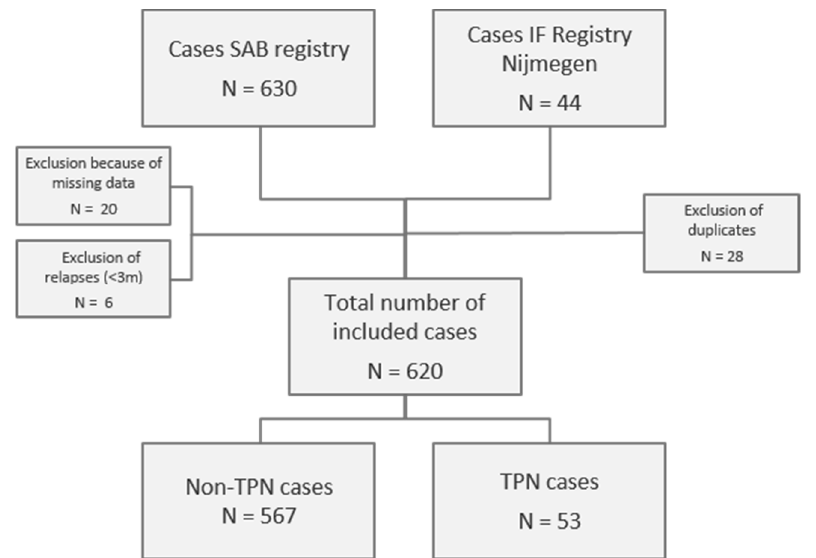
Figure 1. Flowchart of patient acquisition. SAB, Staphylococcus aureus bacteremia; TPN, total parenteral nutrition. Table 1. Comparison of patient characteristics.